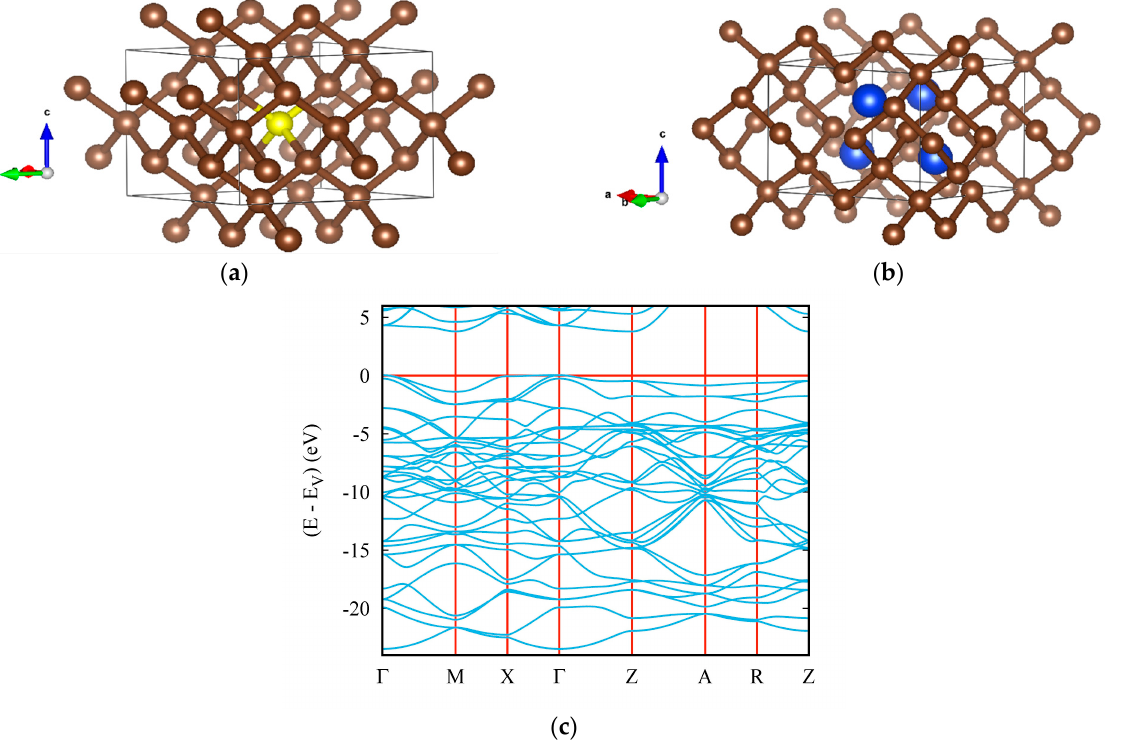
Figure 3. Novel ultrahard carbon subnitride: crystal structures of template diamond-like C 16 ( a ) and tetragonal C 11 N 4 ( b ); electronic band structure of C 11 N 4 ( c ).